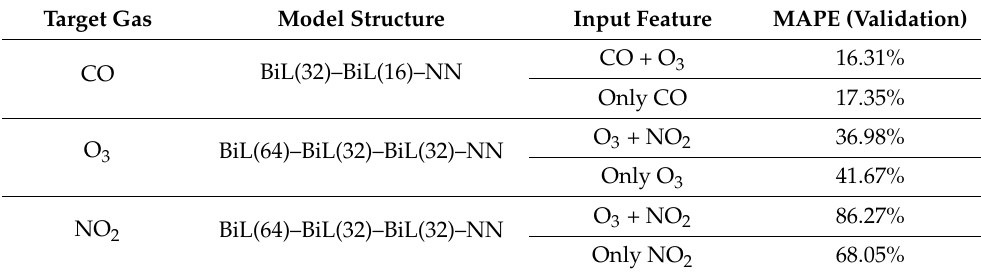
Table 4. Performance differences of target gas models with different model